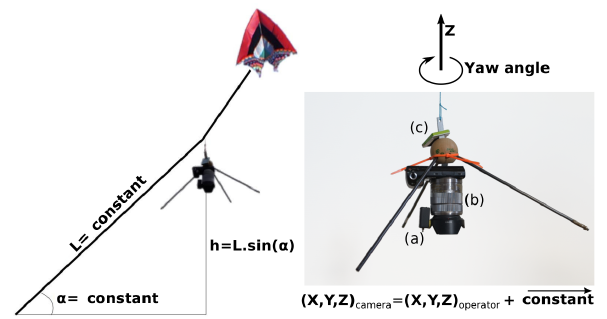
Figure 2. Left: schematic principle of kite image acquisition with a steady flight angle. Right: payload close-up, which consists of a tripod with (a) an automatic trigger (b) a camera and (c) a GPS logger. The yaw angle is the angle of the camera around the z